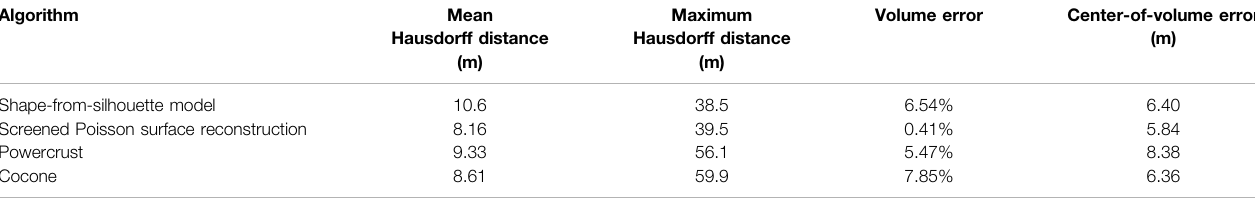
TABLE 3 | Summary of coarse 3D mapping results with 300 features. Algorithm